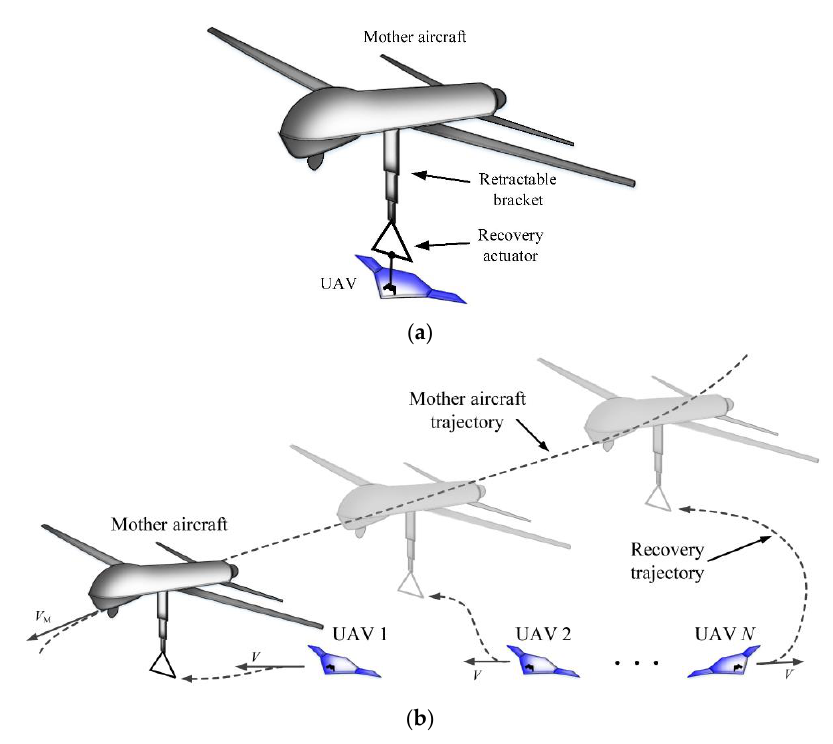
Figure 1. Schematic of the aerial recovery process. ( a ) Single-UAV recovery by using an airborne actuator on the mother aircraft. ( b ) Multi-UAV recovery (in an arbitrary sequence).